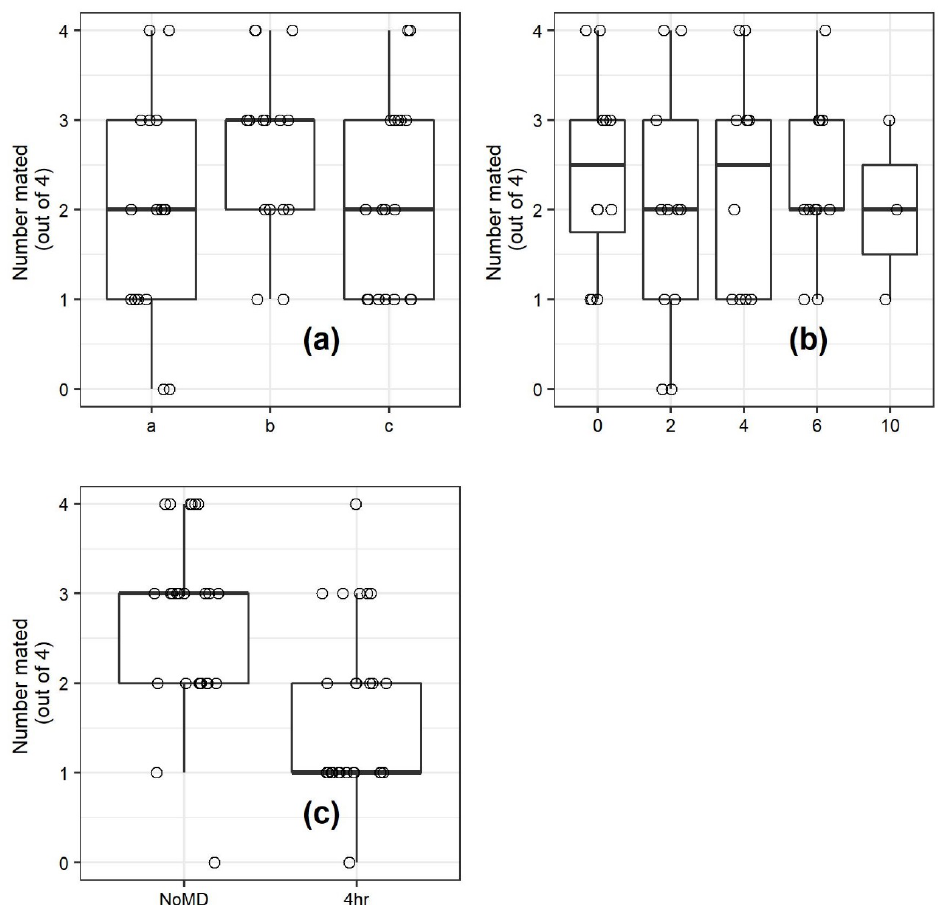
Figure 5. Effect of replicate in time ( a ), previous treatment ( b ), and prior exposure outside the chamber on mating in 208 L chambers ( c ). Males were held in a cage for the first 4 h of the scotoperiod and either exposed to a mating disruption dispenser (4 h) or not (NoMD), then transferred into the chambers. Females were introduced after six hours of scotoperiod. There was no significant e ff ect of day (replicate in time) ( χ 2 = 3.37, df = 2, p = 0.18) or previous treatment ( χ 2 = 0.81, df = 4, p = 0.94. E ff ect of pre-exposure was, however, significant (generalized linear mixed model with binomial distribution, F = 12.07, df = 1, 43, p =